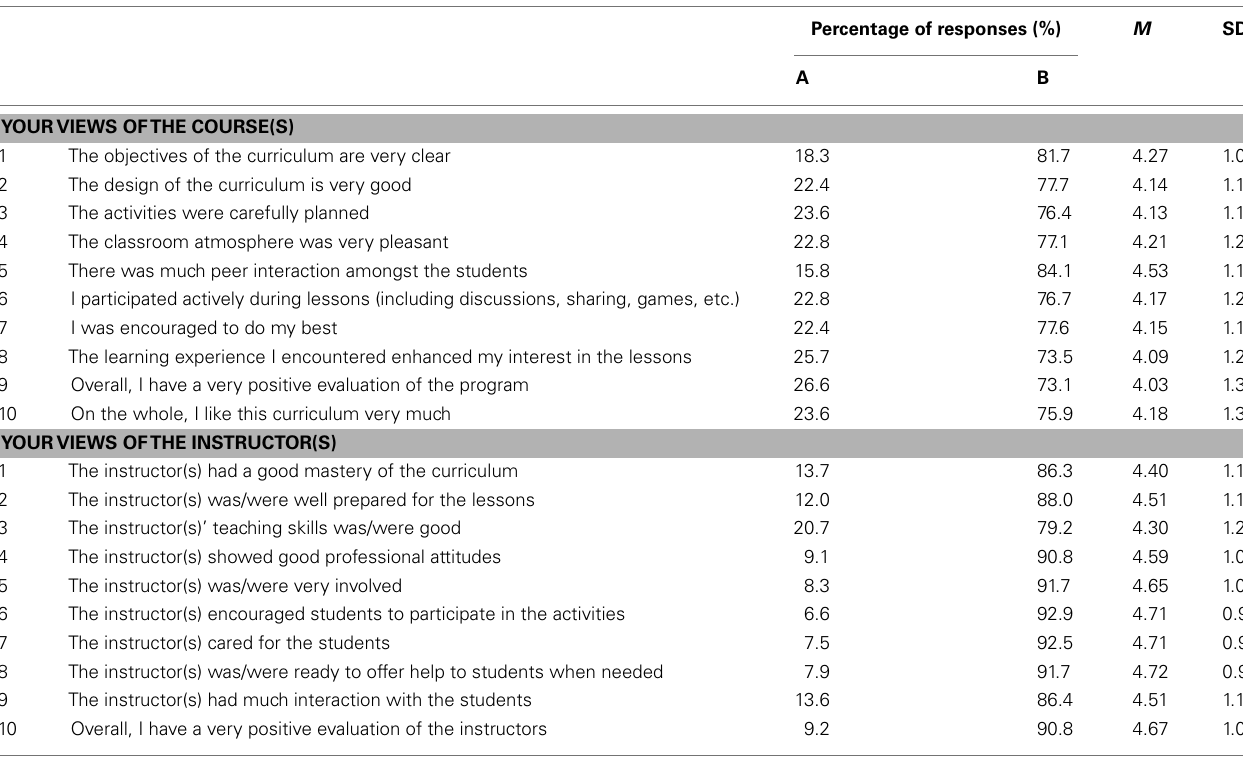
Table 3 | Findings from the subjective outcome evaluation ( n = 241)